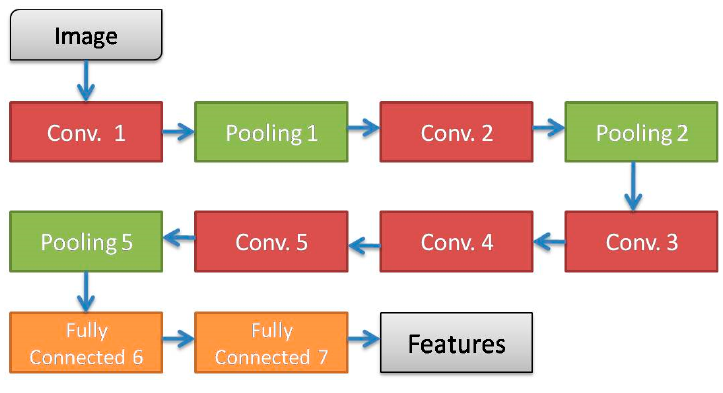
Figure 2. The proposed CNN in